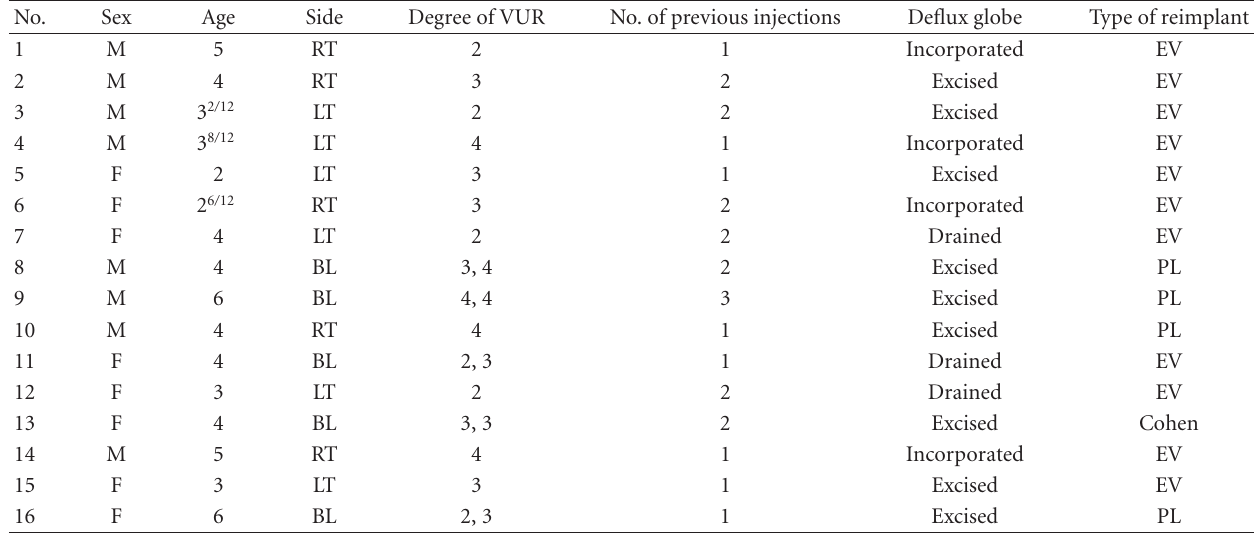
Table 1: Patient’s